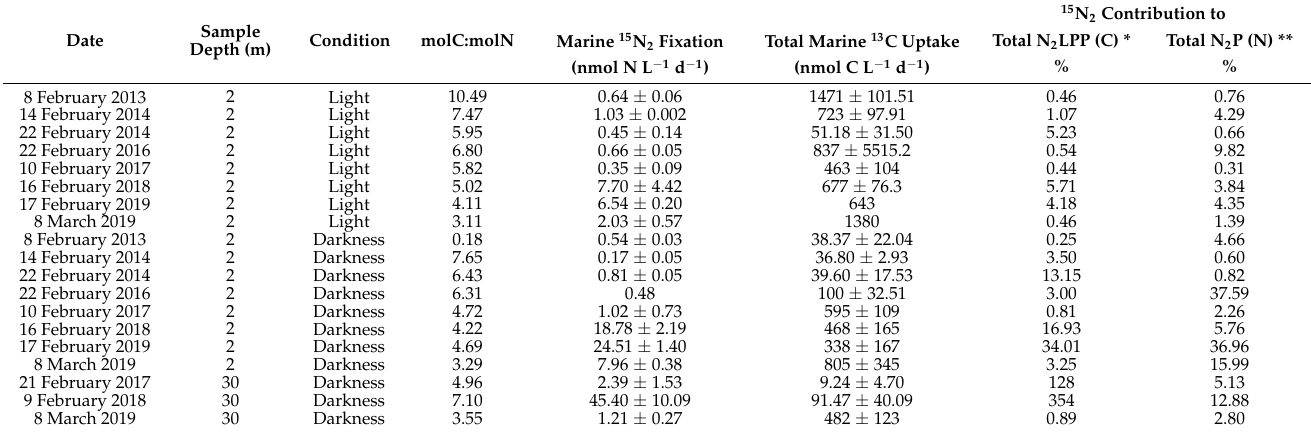
Table 2. Contribution of marine N 2 fixation to local primary production (N 2 LPP) and new production (N 2 NP) in Chile Bay based on the C:N ratio and nitrogen (N 2 ) and carbon (C) fixation rates under light and dark